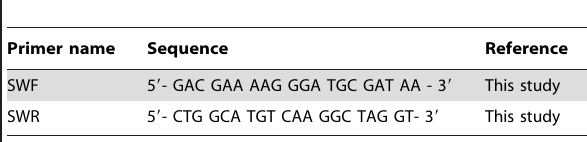
Table 2. Sequences of PCR primers designed in this